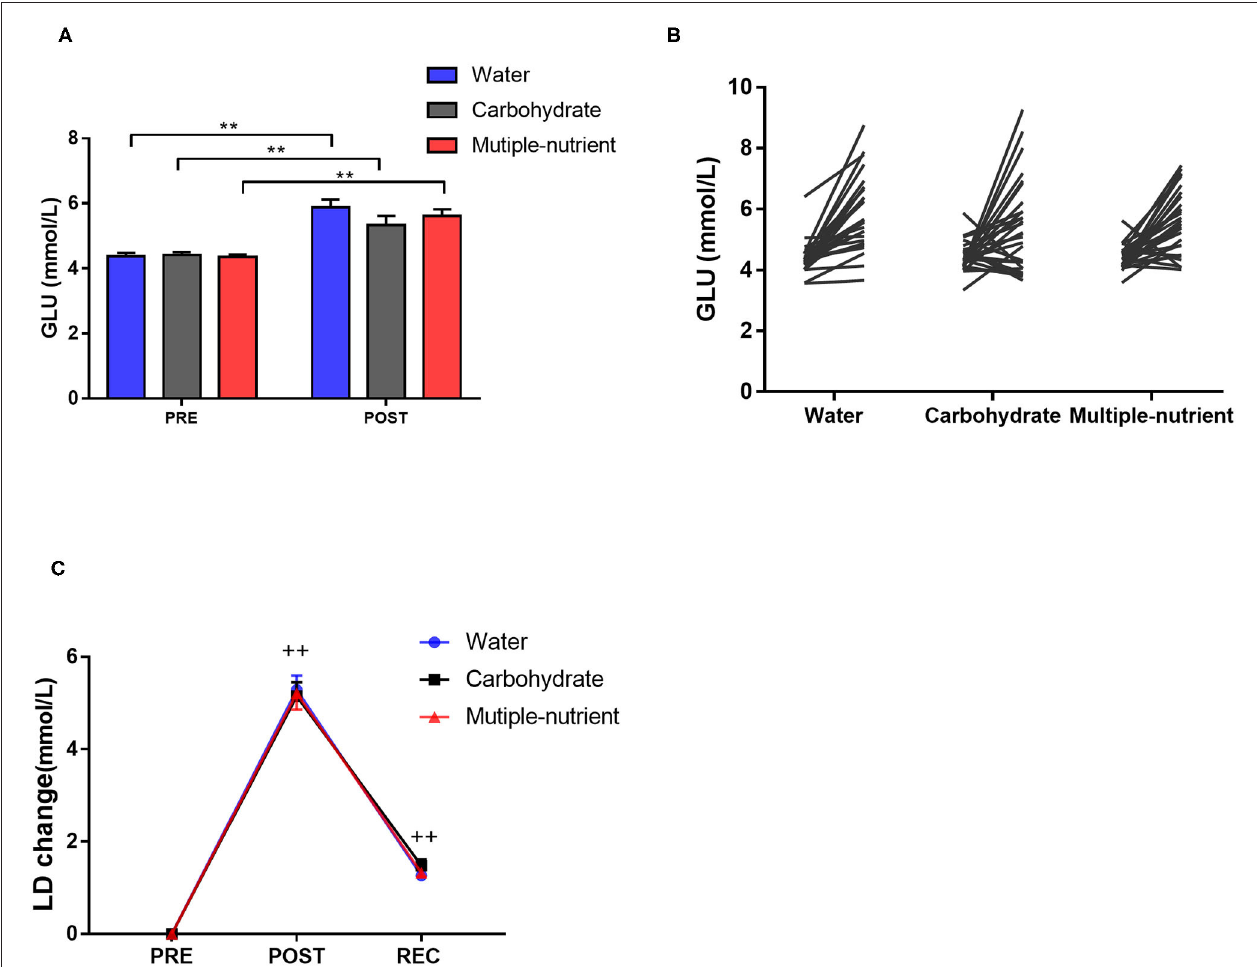
FIGURE 2 | Fatigue-related parameters of each group in the short-term supplement trial. Glucose levels before and after running test (A) . Individual response of each group (B) . Change in lactic acid levels at different time points (C) . Values are mean ± SEM. PRE, prior running test; POST, immediately after running test. **Indicates p < 0.01. ++ Indicates difference compared with PRE, p <